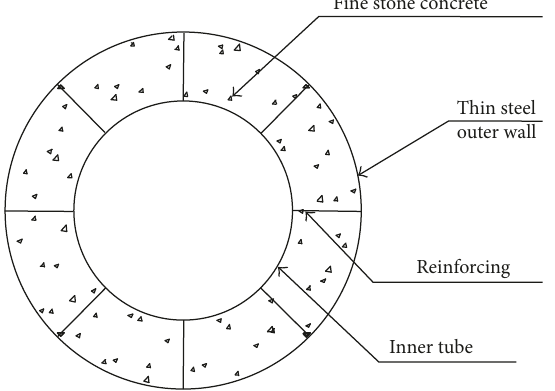
Figure 7: Section type of the stiffener pipe.